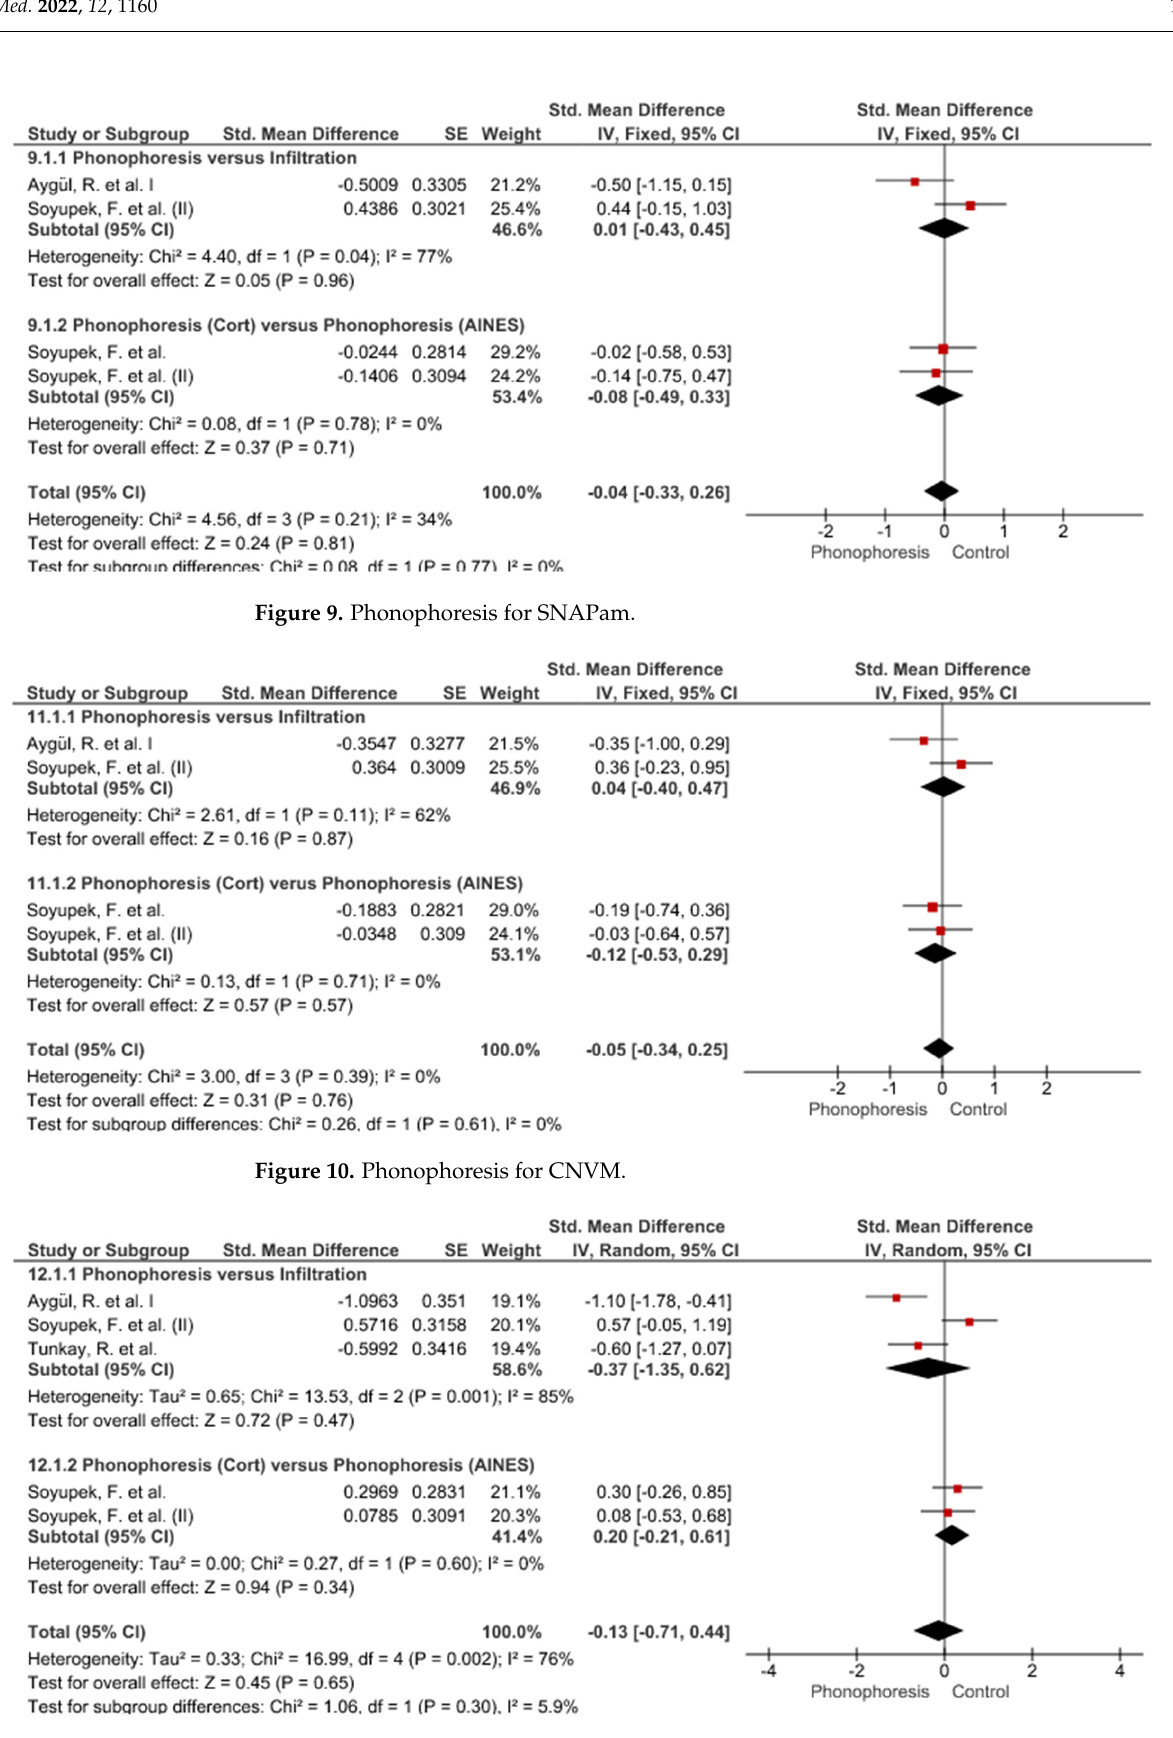
Figure 11. Phonophoresis for CNVS.